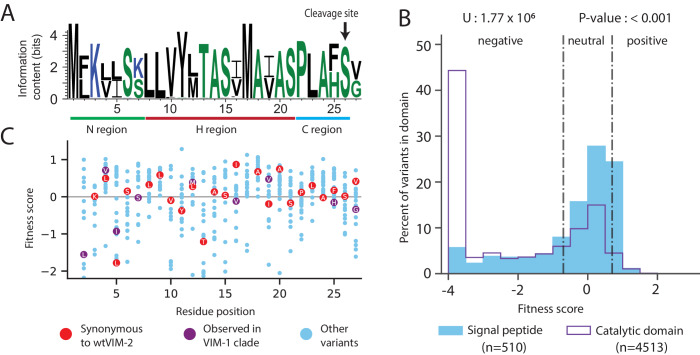
Conservation patterns and fitness scores in the signal peptide.(A) Sequence logo of the signal peptide region aligned across all VIM natural variants generated using WebLogo (https://weblogo.berkeley.edu/). Positions with two major naturally occurring residues are conserved differences between the VIM-1 and VIM-2 clades (clades are defined in Figure 8—figure supplement 1). (B) The distribution of fitness effects of all missense variants, separated into signal peptide variants and catalytic domain variants. The number of variants in each distribution are displayed in the legend below the distributions. The results of a two-tailed Mann-Whitney U test between the distributions are displayed above the distributions. (C) DMS fitness scores of all variants at each position of the signal peptide. Synonymous variants of wtVIM-2 and conserved variants observed in the VIM-1 clade are highlighted as labelled circles. Additional information on codon variant fitness in the signal peptide can be found in Figure 5—figure supplement 1 (replicate correlation of codon variant fitness), Figure 5—figure supplement 2 (heat map of codon variant fitness) and Figure 5—figure supplement 3 (correlation between RNA folding energy and codon variant fitness).